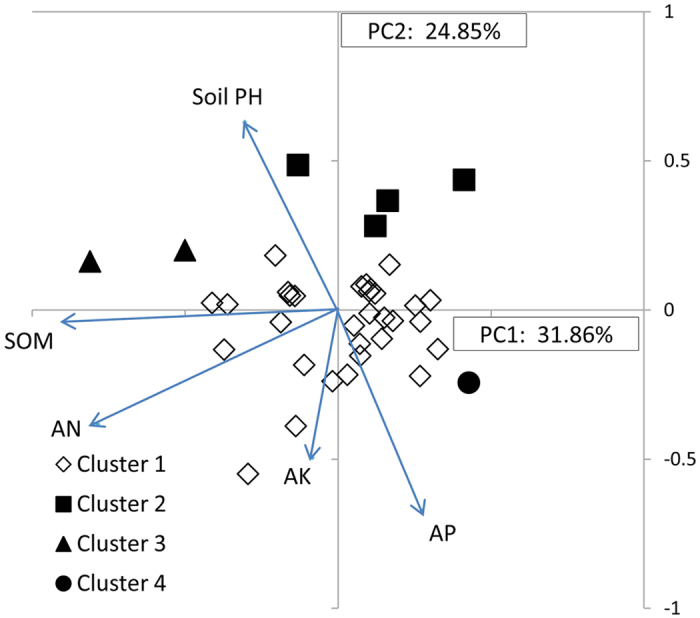
Principal components analysis of 38 soil samples of the faba bean production areas.Variable factor loadings for PC1 and PC2 were soil pH and soil nutrient variables and presented as vectors.